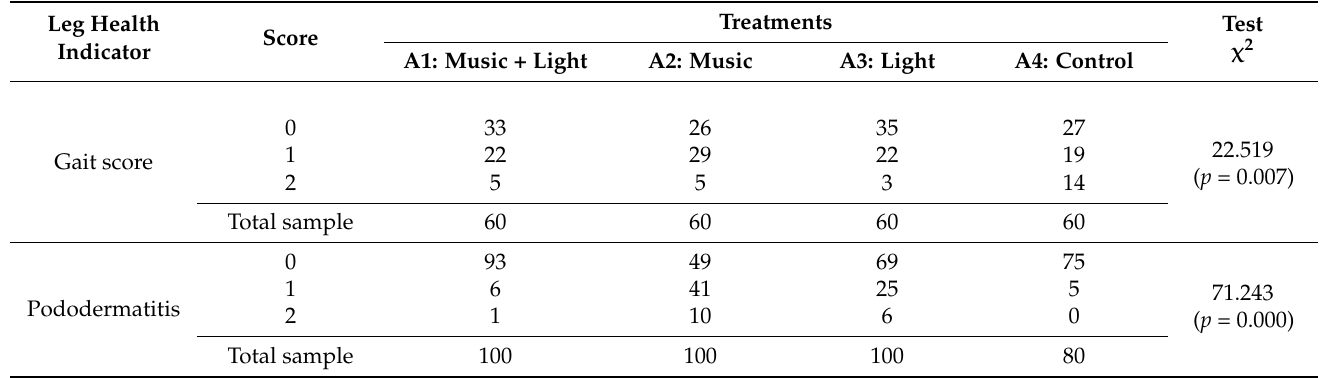
Table 2. The number of birds observed from the total sample with different degrees of gait score and pododermatitis for each